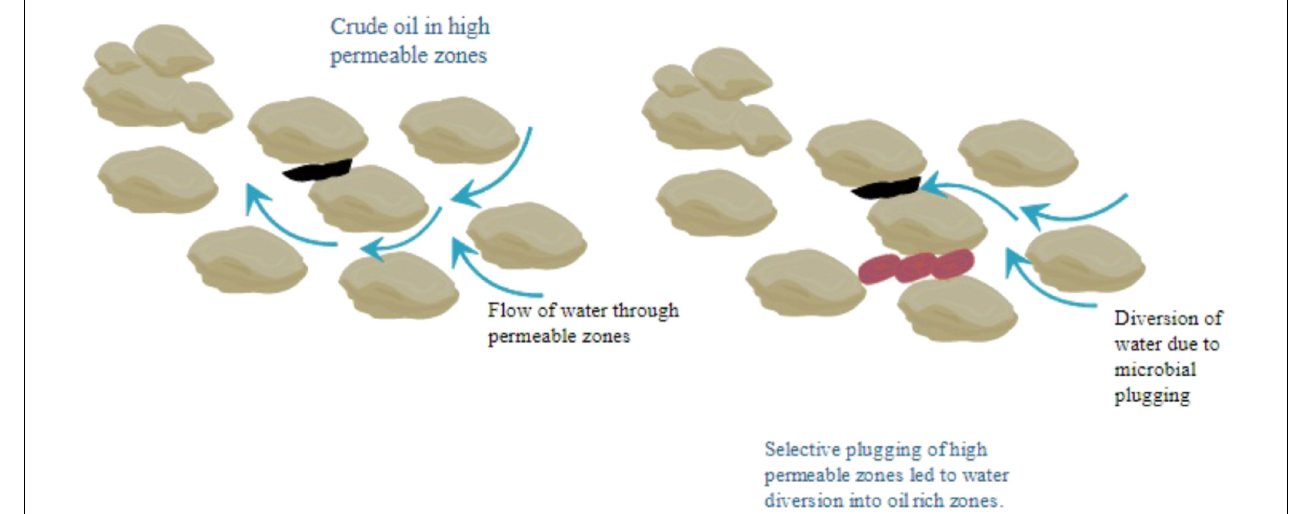
FIGURE 1 | Schematic of bacterial profile modification.